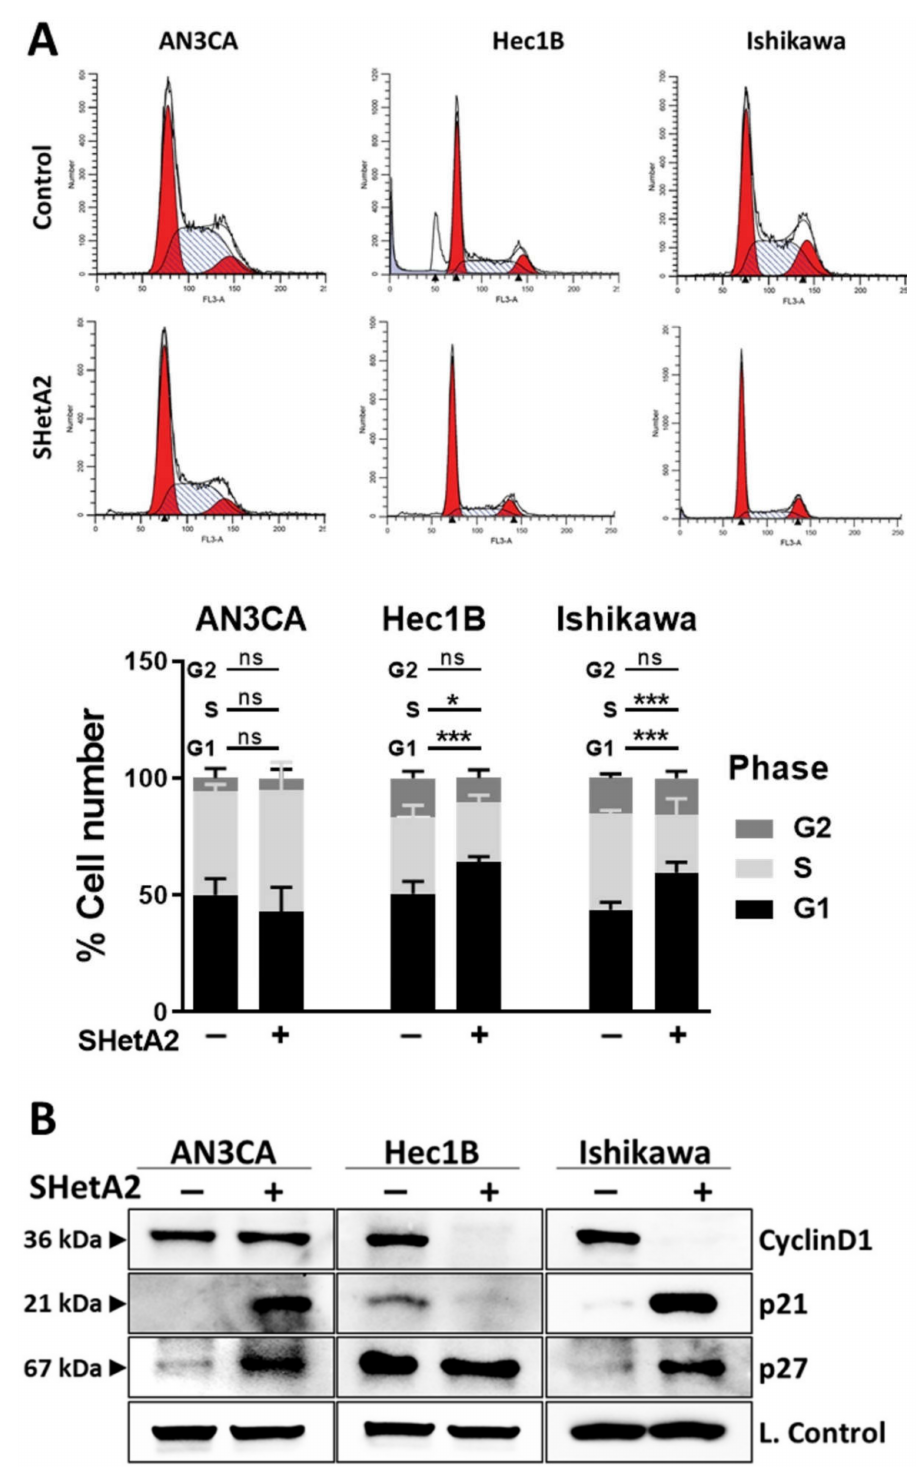
Figure 2. SHetA2 induces cell cycle arrest and alters expression of cell cycle regulatory proteins: ( A ) Flow cytometry analysis of endometrial cancer cells treated with SHetA2 (10 µ M) or vehicle for 24 h followed by PI staining. Representative images of cell cycle distributions are shown (upper panel). Percentages of the cell population at different cell cycle phases were calculated from three independent experiments and shown in the bar graph (Lower panel). ( B ) Western blot analysis of cell cycle regulatory proteins isolated from endometrial cancer cells treated with SHetA2 (10 µ M) or vehicle for 24 h. * p ≤ 0.05, *** p ≤ 0.001 when compared with respective